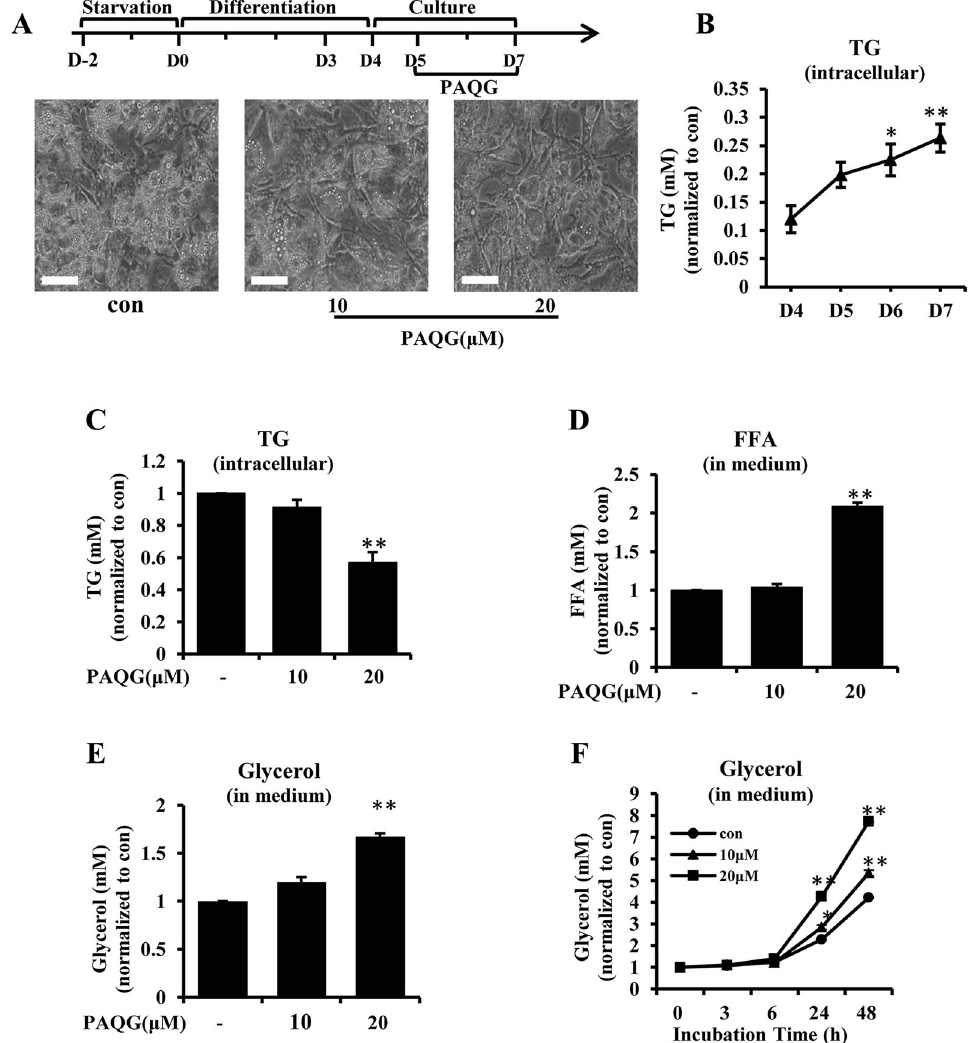
Fig. 3 PAQG regulates lipid metabolism in adipocytes. Differenti- ated adipocytes were treated with indicated concentrations of PAQG for 48 h. a The treatment protocol (up panel) and photographs (down panel). b , c The TG levels in differentiated 3T3-L1 cells, which were treated with various concentrations of PAQG or vehicle